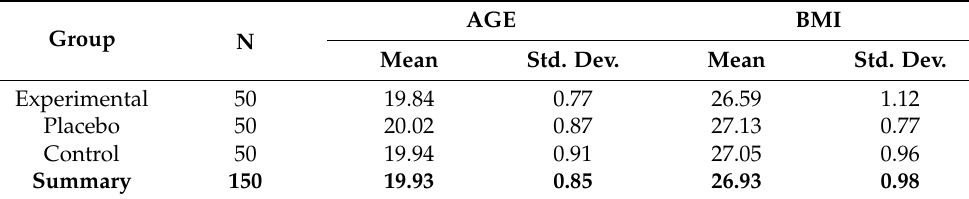
Table 1. Subjects